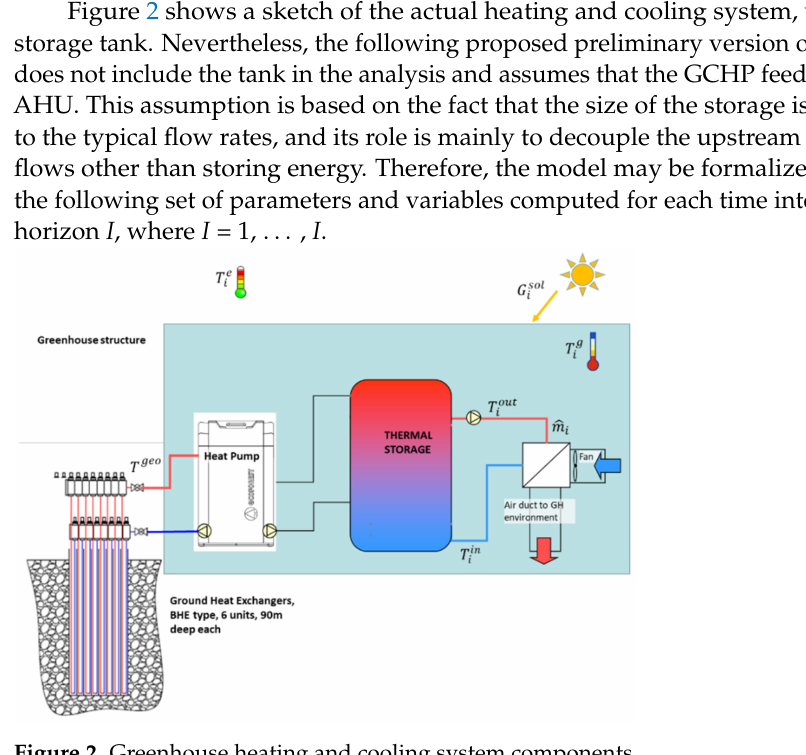
Figure 2. Greenhouse heating and cooling system